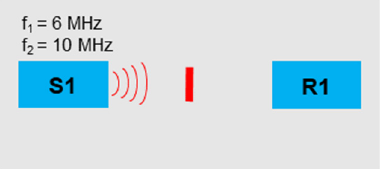
Figure 11. Nonlinearity parameter: ( a ) f 1 = 6 MHz; ( b ) f 1 = 10 MHz.